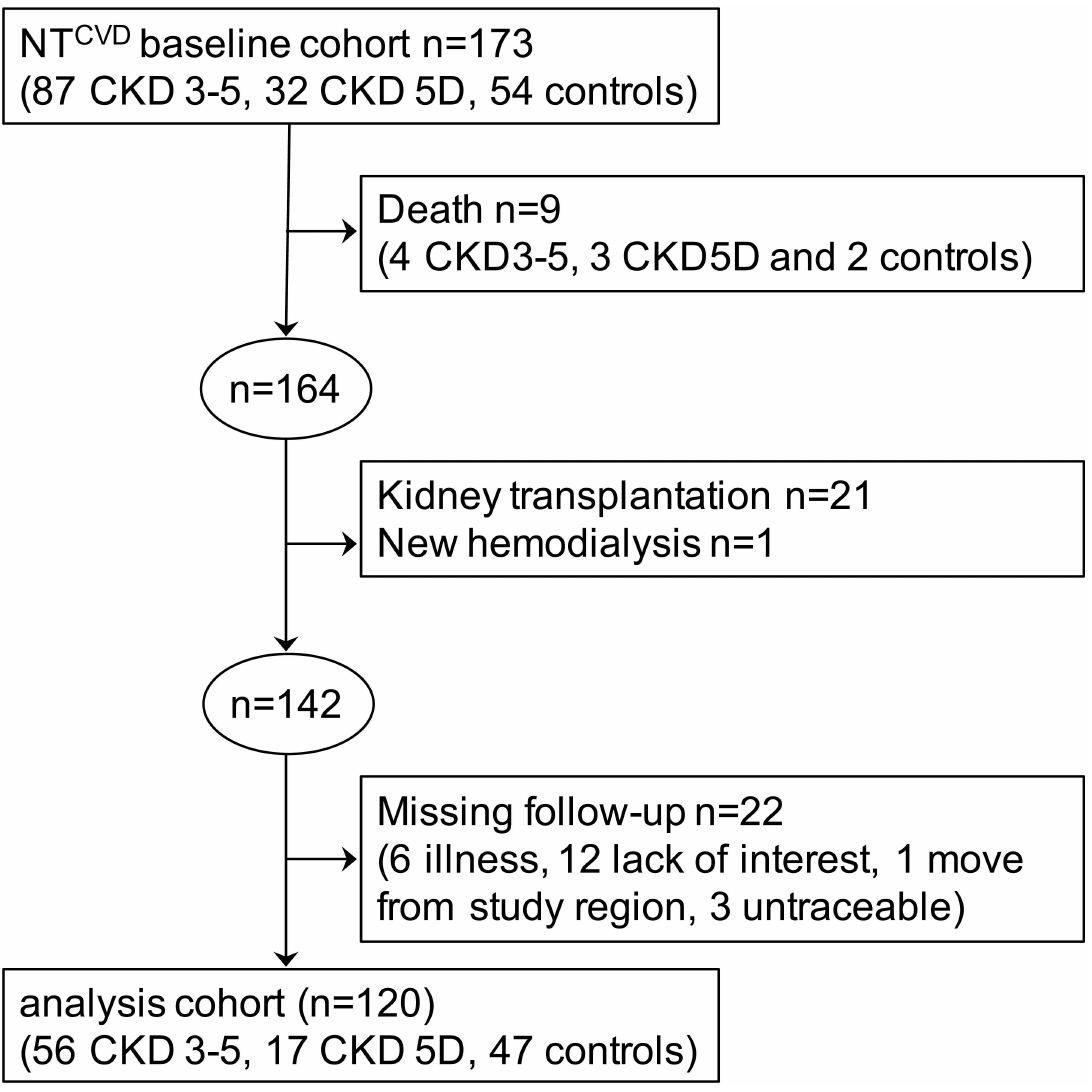
Fig 1. Flow chart of the NT CVD 2-year follow-up study. Numbers of patients includedand excludedin the follow-upanalysis are shown. CKD, chronic kidney disease.NT CVD , New Tools for the Preventionof Cardiovascular Disease in ChronicKidney